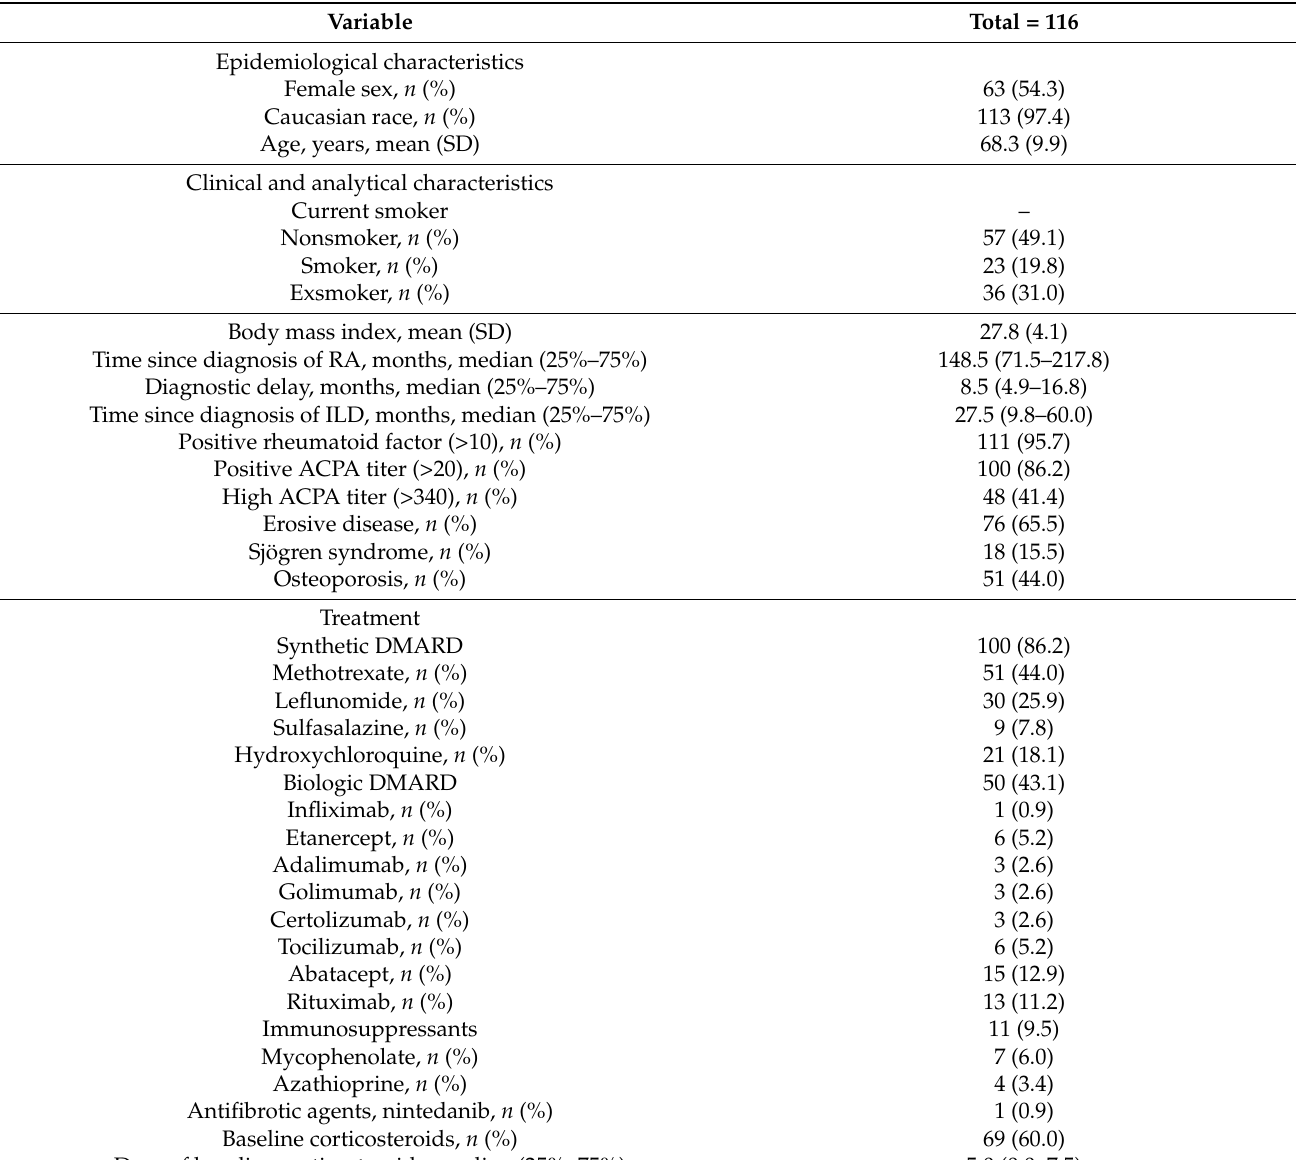
Table 1. Baseline characteristics of 116 with RA-ILD treated with